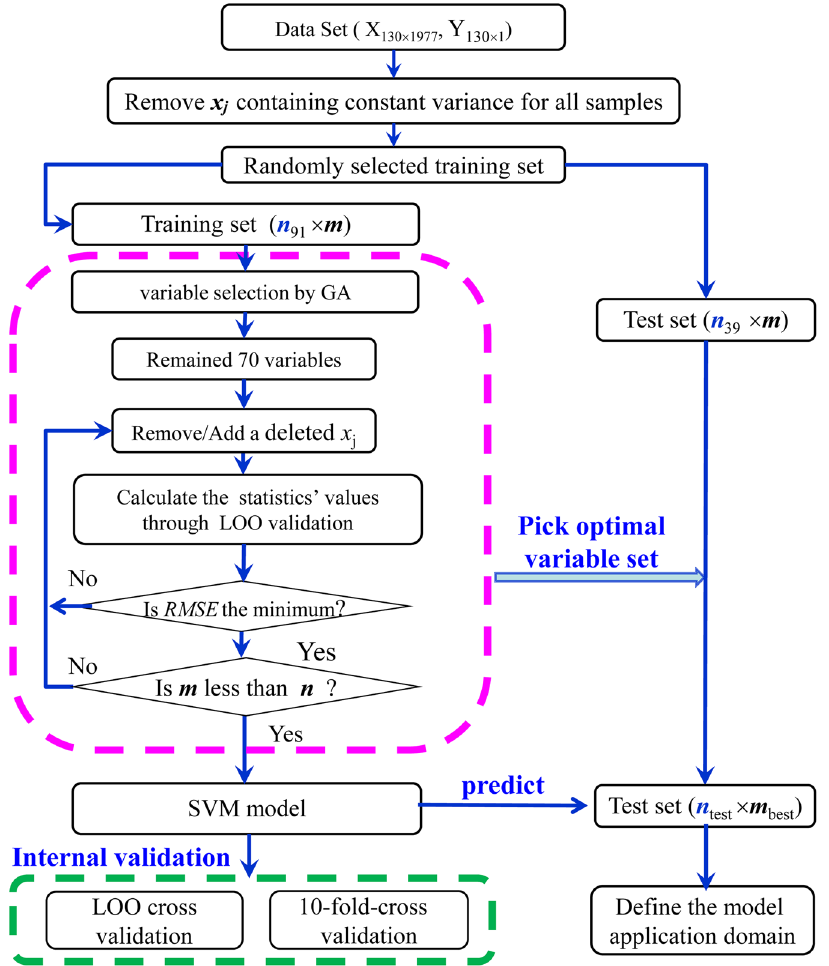
Figure 5. Flow chart of the model